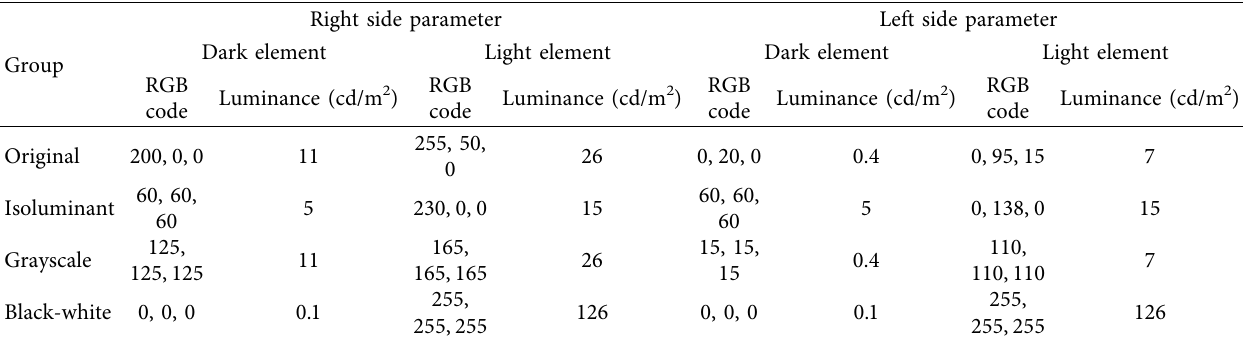
Figure 2: Top left corner of plate I of the TNO stereo test is used to get the picture parameter: (a) mounting red filter in front of a 50mm lens; (b) mounting green filter in front of a 50mm lens. The shooting parameter is ISO 800, the aperture value is 2.8, and the shutter speed is 1/ 200s. Table 1: Detailed parameters of test